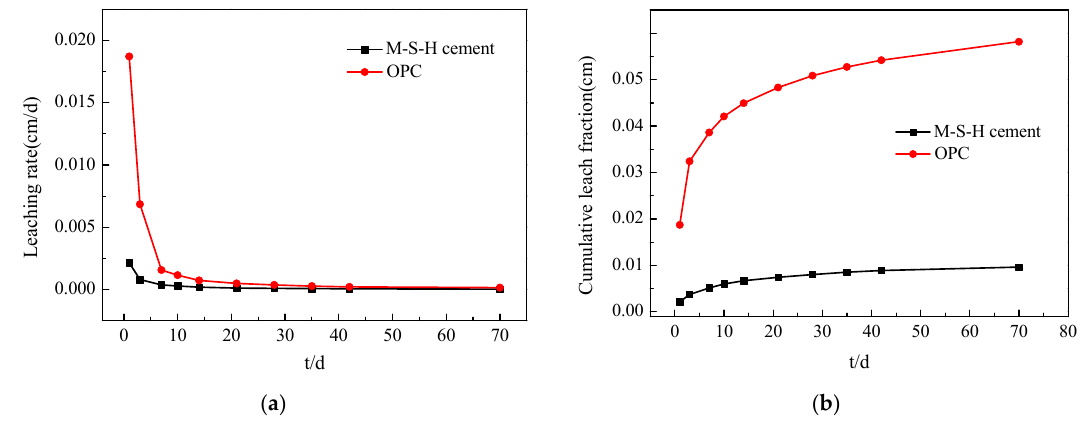
Figure 10. Leaching rate ( a ) and cumulative leach fraction ( b ) of different cement-solidified bodies.